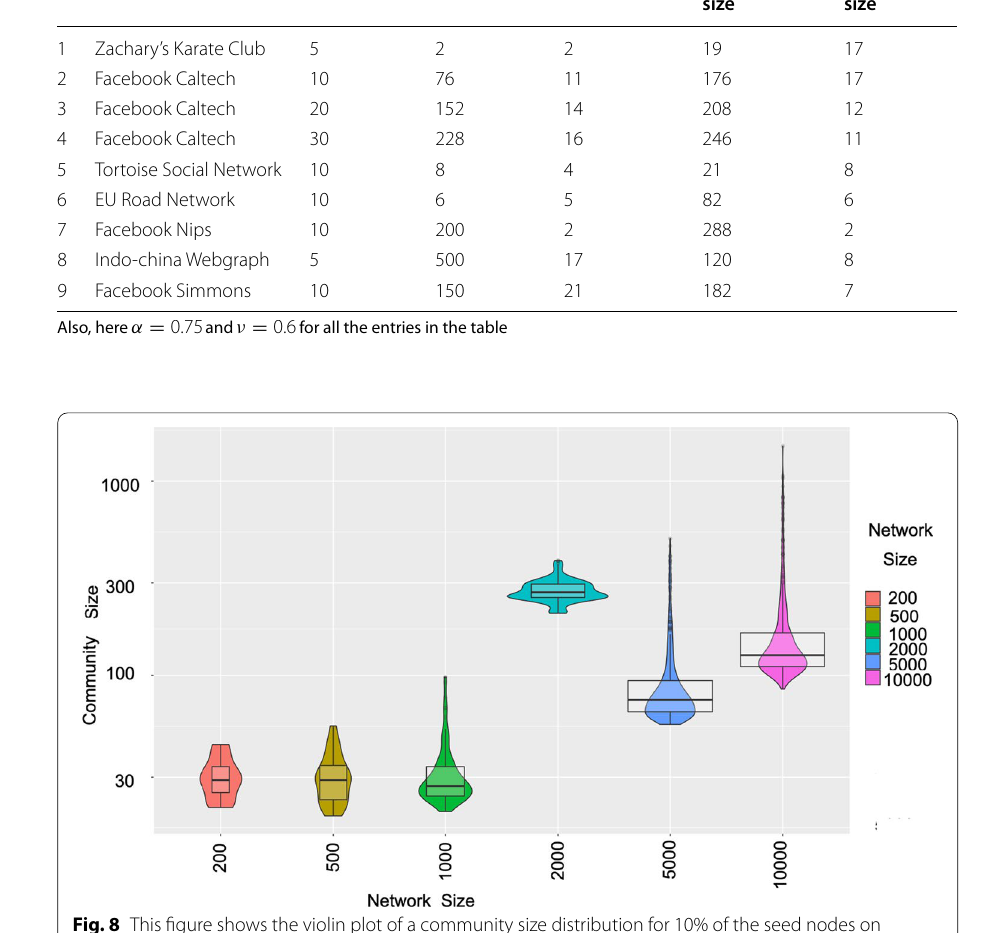
Table 7 Some statistics of the Preference Implication-based method results of communities created on the unweighted real networks from Table 5 of real networks with different sizes of seed nodes